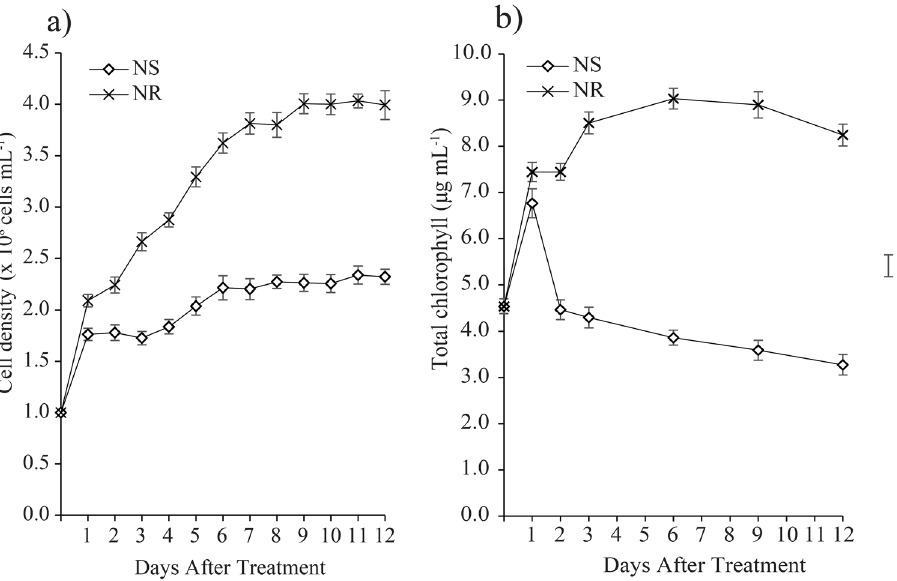
Figure 1. Effects of nitrate starvation on M. gracile SE-MC4 cultivation. ( a ) Growth curve of M. gracile during 12 days of cultivation under nitrate-starve (NS) and nitrate-replete (NR) conditions. ( b ) Total chlorophyll of M. gracile during early (day 1, 2 and 3), mid (day 6 and 9) and prolong (day 12) exposure periods under NS and NR conditions. The values are presented as means ± standard deviation (SD) (n =